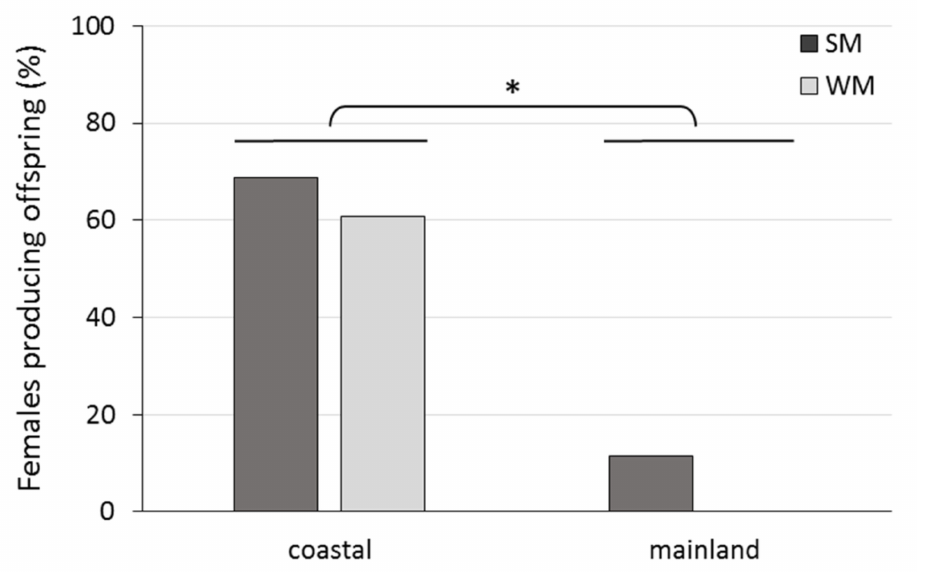
Figure 6. Percentage of SM and WM females that produced offspring during their exposure to field conditions of a coastal (Volos) and a mainland (Naousa) area from 1 November 2019 until the death of all individuals in May 2020. Values within the chart below the asterisk differ significantly ( p < 0.001). The area (coastal, mainland) where females overwintered strongly affected the pro- duction of progeny, with 92.3% less pupae recorded in the mainland than in the coastal area (IRR (95% CI) = 0.077 (0.011, 0.515), p = 0.008). WM females produced 67.1% less progeny than SM females (IRR (95% CI) = 0.329 (0.169, 0.639), p = 0.001), adjusting for area, ambient temperature and days spent in the field (Table 3, Figure 8). Also, SM females produced 38.9 times more progeny in the coastal than in the mainland area (IRR (95% CI) = 38.9 (10.7, 141.0), p < 0.001), and 3.03 times more progeny than WM females in the coastal area (IRR (95% CI) = 3.03 (1.56, 5.87), p = 0.006) (Table 3, Figure